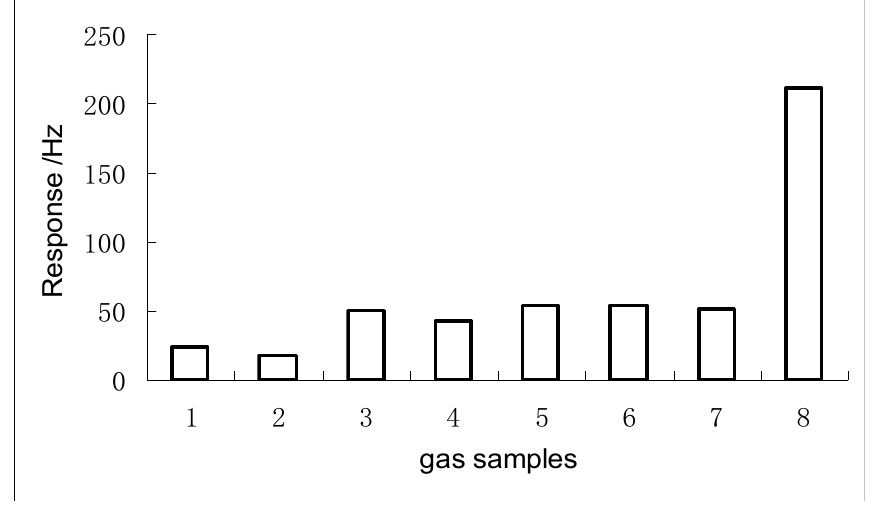
Figure 6. The response of the sensor to different 10 ppm sample gases (from left to right). 1, methanol; 2, ethanol; 3, formal dehyde; 4, acetal dehyde; 5, ethyl acetate; 6, n-hexane; 7, chloroform; 8,